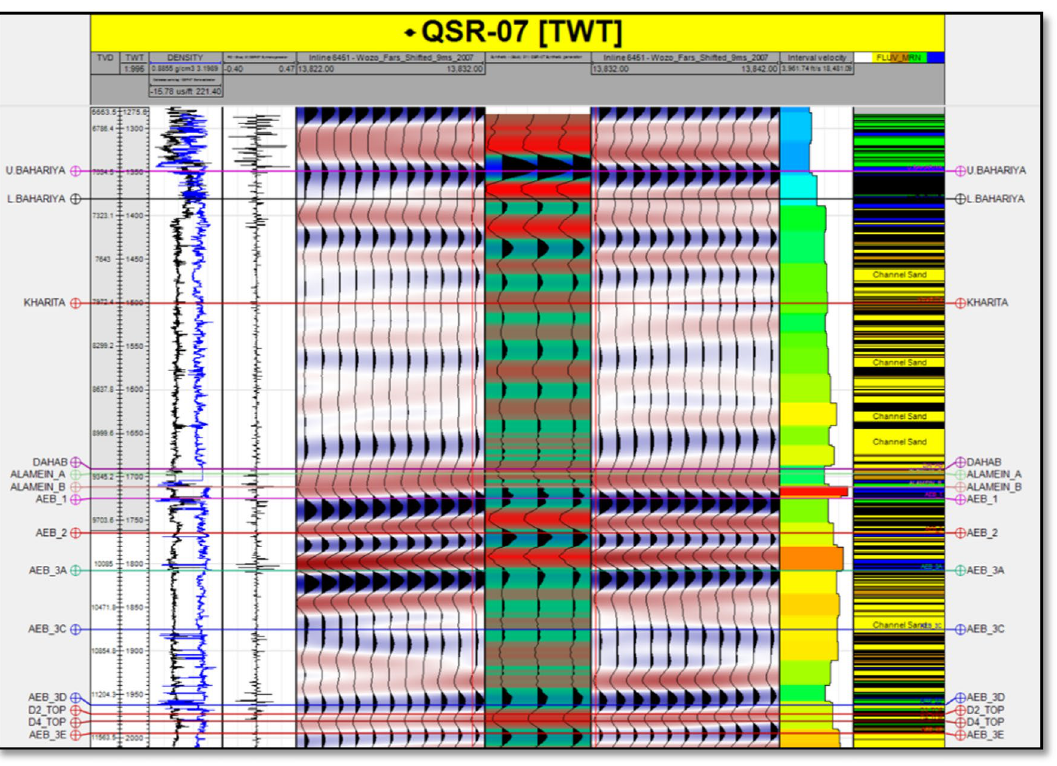
Fig. 10 Synthetic seismogram of well Qasr-07, depth–TWT relationship with linear depth scale. Note that the sandstone is shown by yellow color on the lithology column to